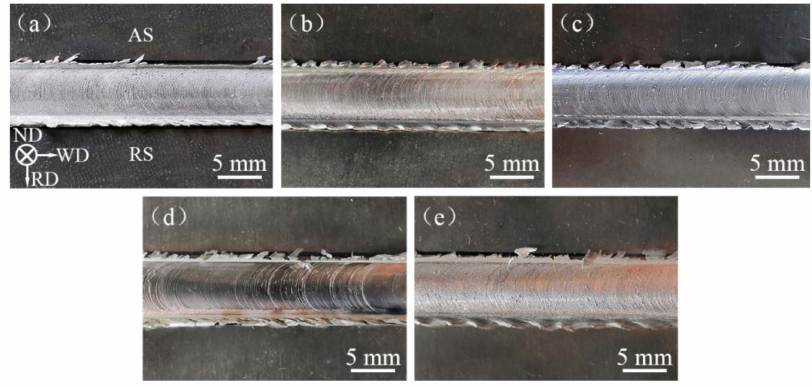
Figure 6. Surface appearances of joints produced using parameters of ( a ) 3000-600-P-Fe, ( b ) 6000-600-P-Fe, ( c ) 6000-1200-P-Fe, ( d ) 6000-600-PL-Fe, and ( e ) 6000-600-P-Cu.